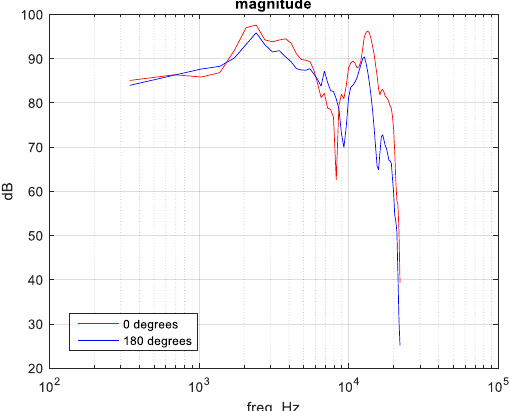
Figure 9. Effects on listening experience when the listener is ( a ) facing or ( b ) turning her or his back to the loudspeaker.